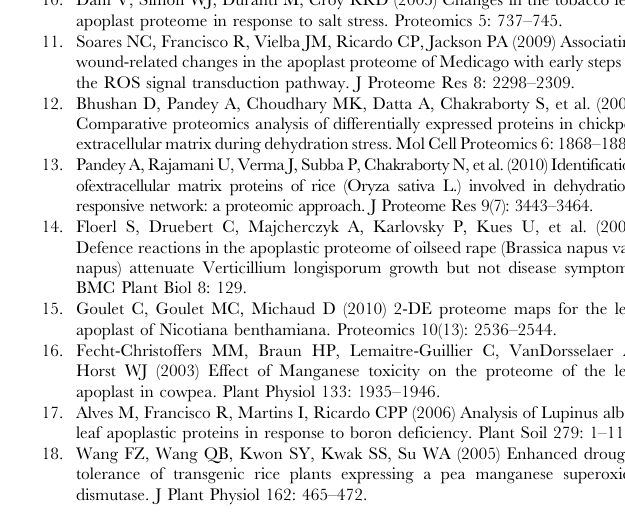
Figure S1 Proteins identified related with carbohydrate metab- olism and redox homeostasis in response to H 2 O 2 .